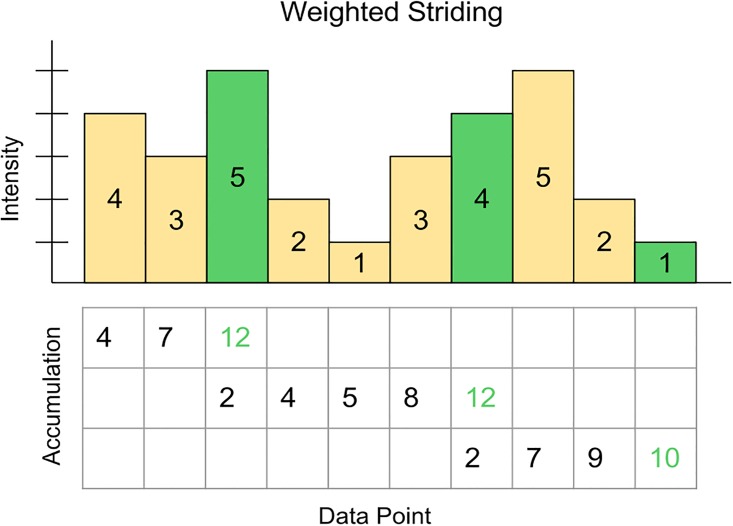
Weighted striding summarization.The weighted striding technique promotes higher intensity points while still admitting low intensity points to achieve a representative sub-sample. Shown here with10 points total, total intensity = 30, stride length = 1, sample size = 3, and accumulation threshold = 10.